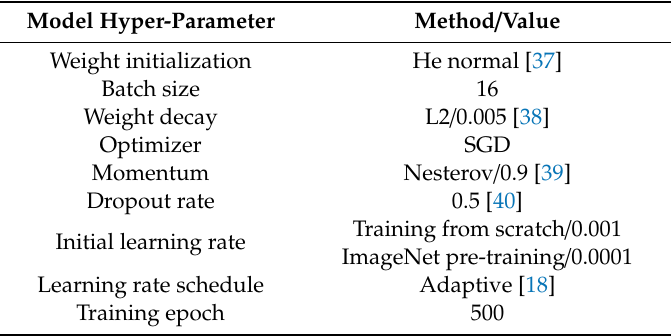
Table 4. Hyper-parameters for training models.